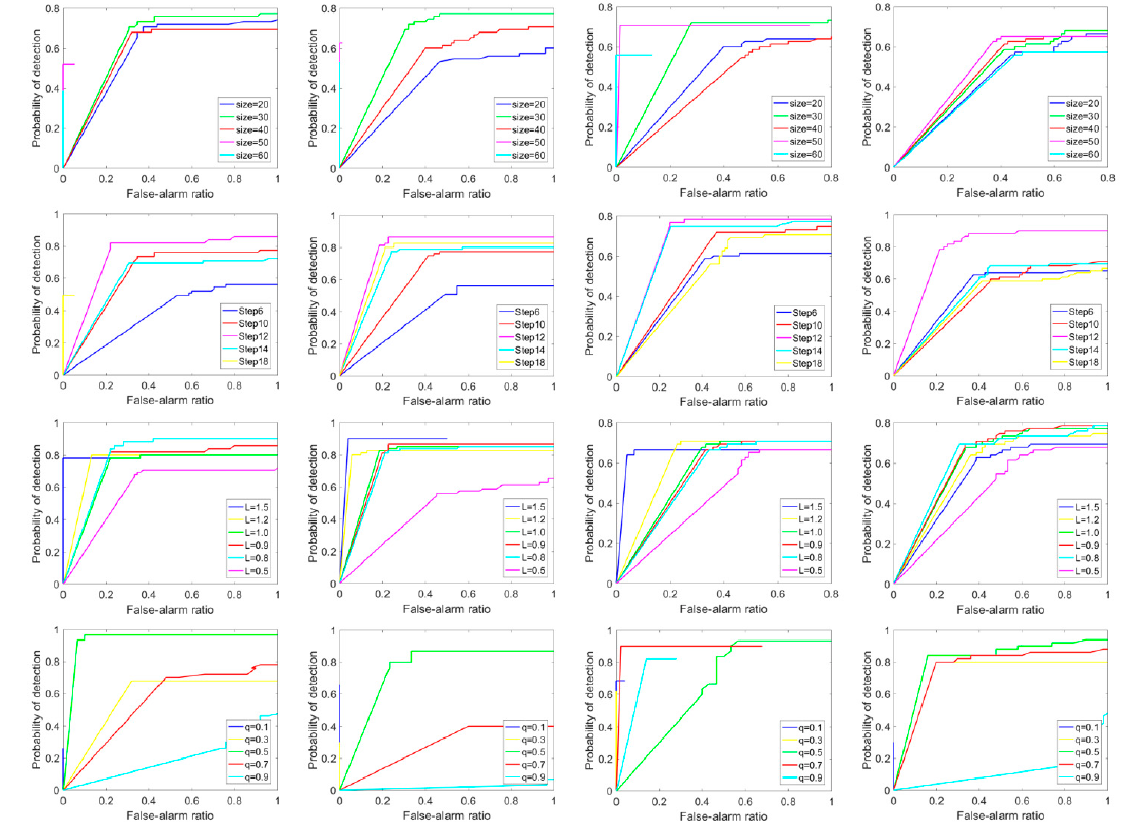
Figure 17. ROC curves of sequences 1–4 with respect to different parameters. Row 1 : Different patch sizes. Row 2 : Different sliding steps. Row 3 : Different sparse penalty. Row 4 : Different weight factor.